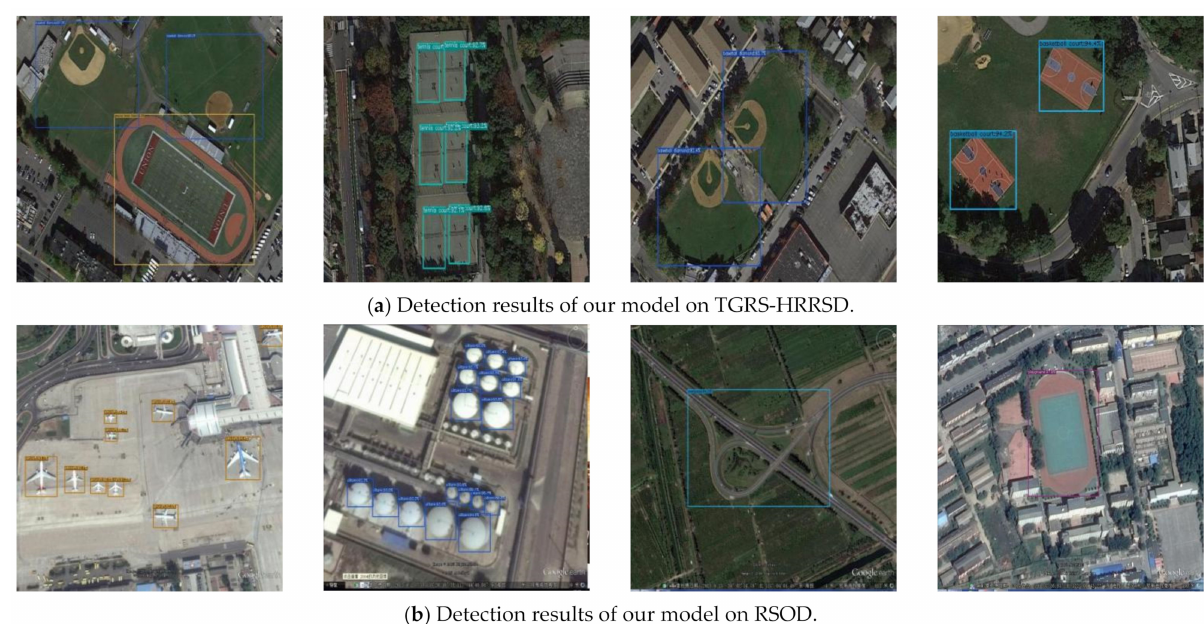
Figure 12. Detection results of our model on TGRS-HRRSD and RSOD. ( a ) From left to right, the photographs show ground track fields, tennis courts, baseball diamonds, and basketball courts.